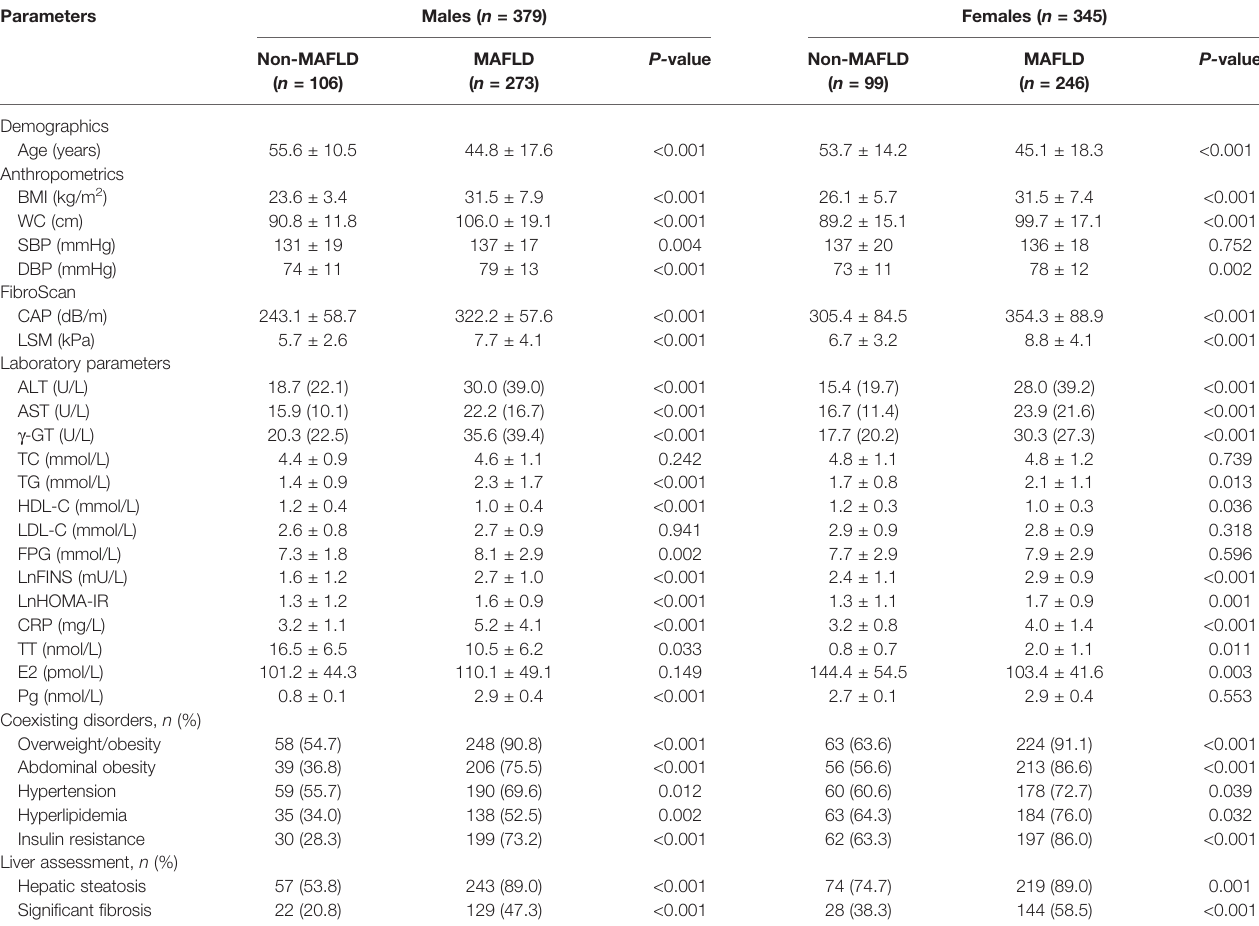
TABLE 1 | Baseline metabolic characteristics of the study cohort strati fi ed by MAFLD status in both genders.